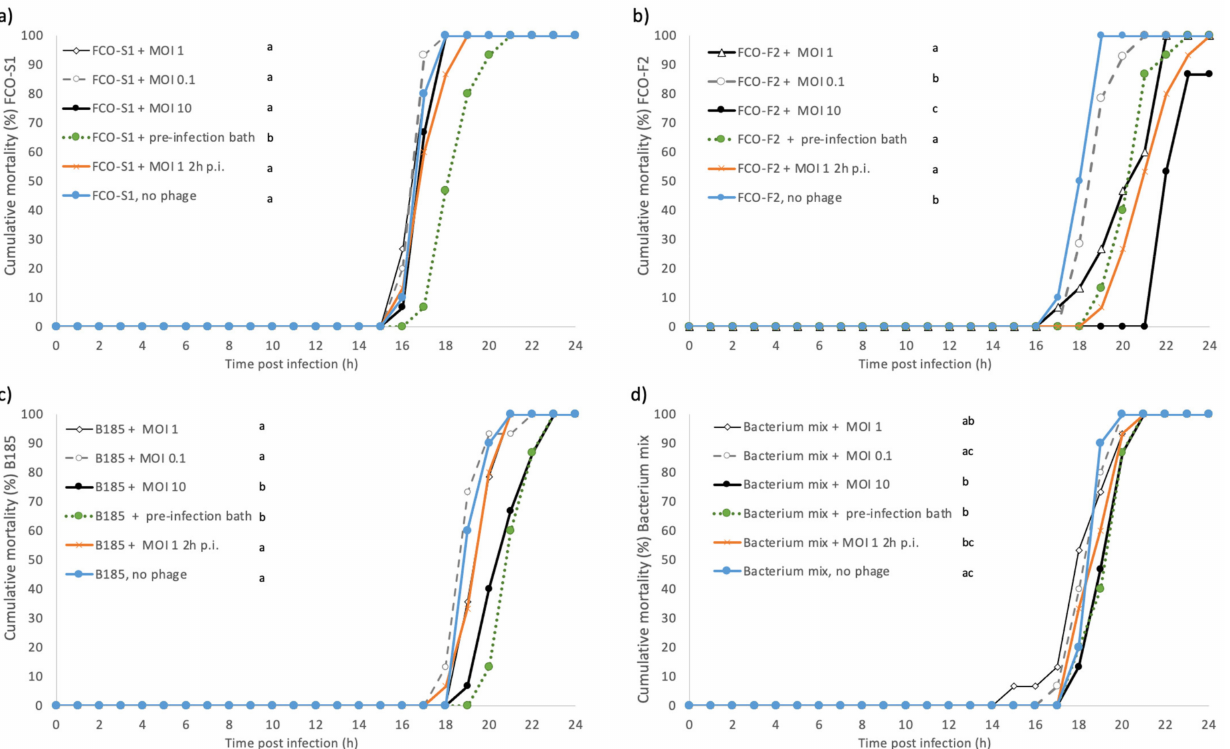
Figure 3. Experiment II: Cumulative mortalities (%) of rainbow trout fry infected with Flavobacterium columnare isolates ( a ) FCO-S1, ( b ) FCO-F2 ( c ) B185, and ( d ) their mix, and treated with a mix of phages FCOV-S1, FCO-F27, and FCL-2. Phage mixes were added at the same time as bacteria (0 h) at MOI 1, 0.1, and 10, 2 h post-bacterial infection at MOI 1 (MOI 1 2 h post-infection, p.i.) or given as a 2-h bath exposure at MOI 1 before adding the bacteria (pre-infection bath). Different lower-case letters a-c indicate statistical difference ( p < 0.05, Kaplan–Meier survival analysis, log rank pairwise comparisons, Mantel–Cox) between the treatment groups ( n = 15 in phage treatments, n = 10 in controls, total n =